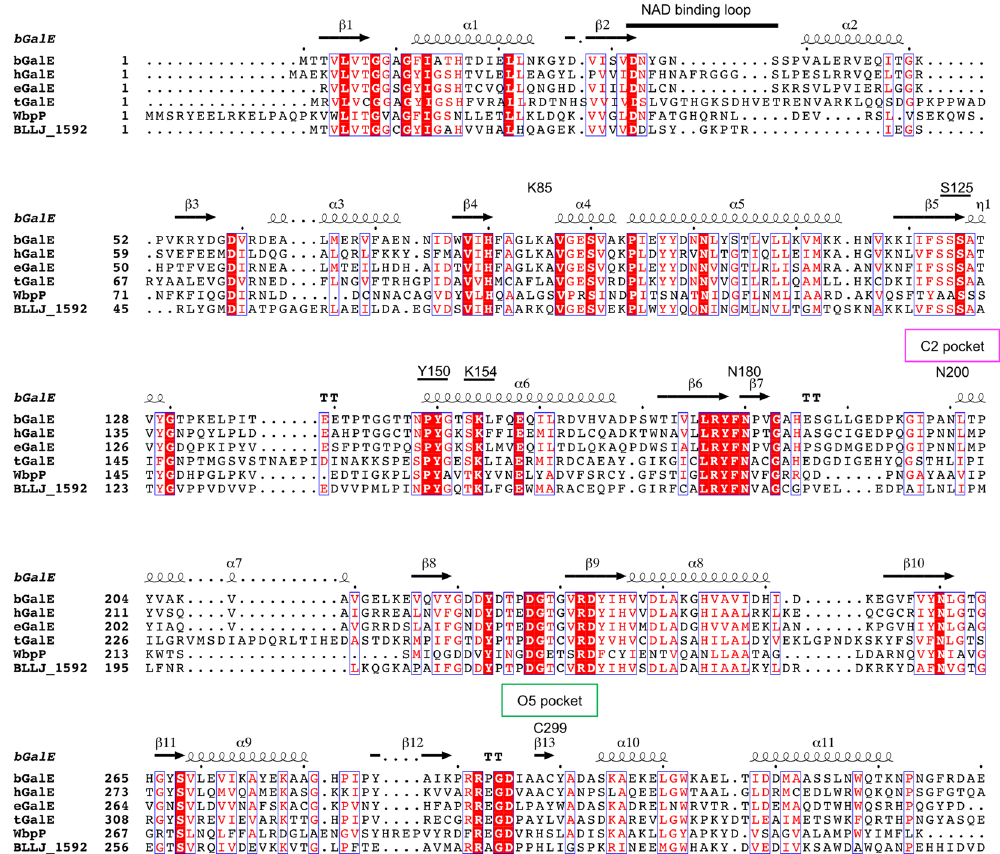
Figure 5. Amino acid sequence alignment of GalEs. Representatives of group 2 (bGalE and hGalE), group 1b (eGalE), group 1a (tGalE), group 3 (WbpP), and a paralog of bGalE (BLLJ_1592) are shown. The catalytic triad residues are